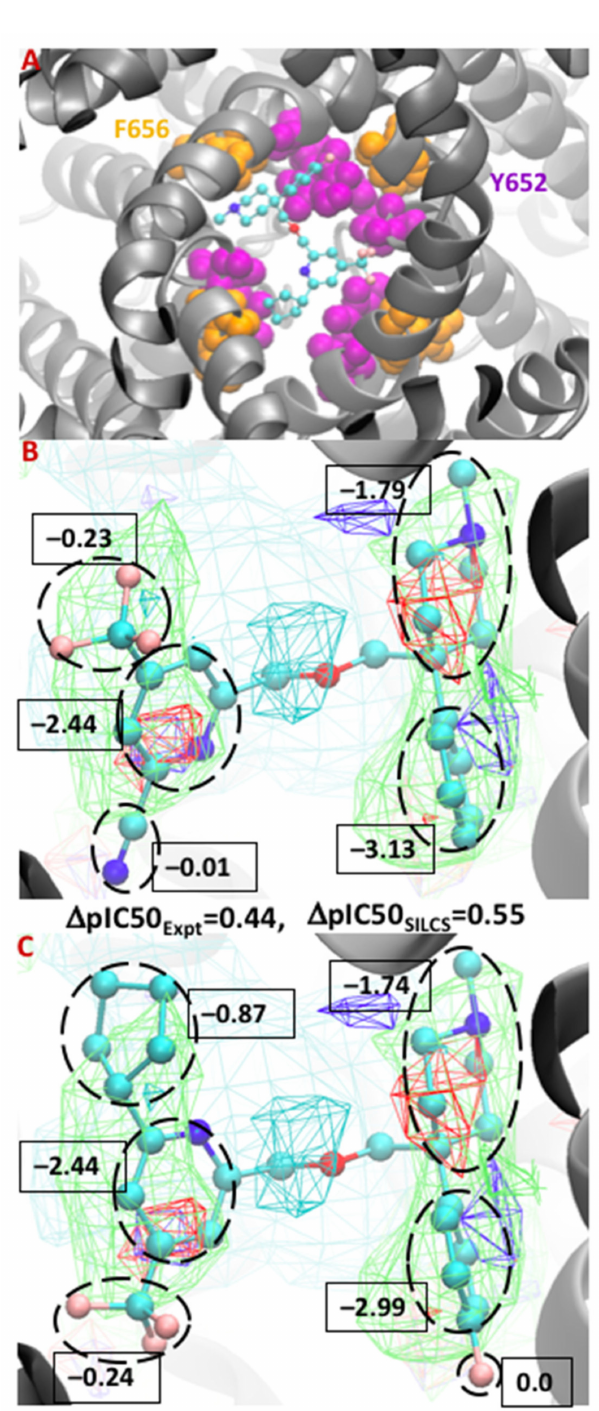
Figure 3. Binding orientation of a compound (from Gillman et al. [93]) in the S1 pocket in the vicinity of residues F656 and Y652 ( A ). Atomic GFE moiety contributions between the minimum conformation of the congeneric ligands 38 and 51 from test set 1 ( B , C ). The FragMaps colors are hydrophobic (GENN or APOLAR, green), hydrogen bond acceptor (GENA, red), hydrogen-bond donor (GEND, blue), and positive (MAMN, cyan). The FragMap isocontour surfaces are displayed at a cutoff of − 0.8 kcal/mol for the apolar groups and rest of them at − 1.0 kcal/mol. The atom cyan, blue, red, and pink colors represent carbon, nitrogen, oxygen, and fluorine atoms, respectively. A comparison of the two ligands shows two modifications on each side of the con- generic molecules. On the right side of the molecule, the benzene ring of the ligand